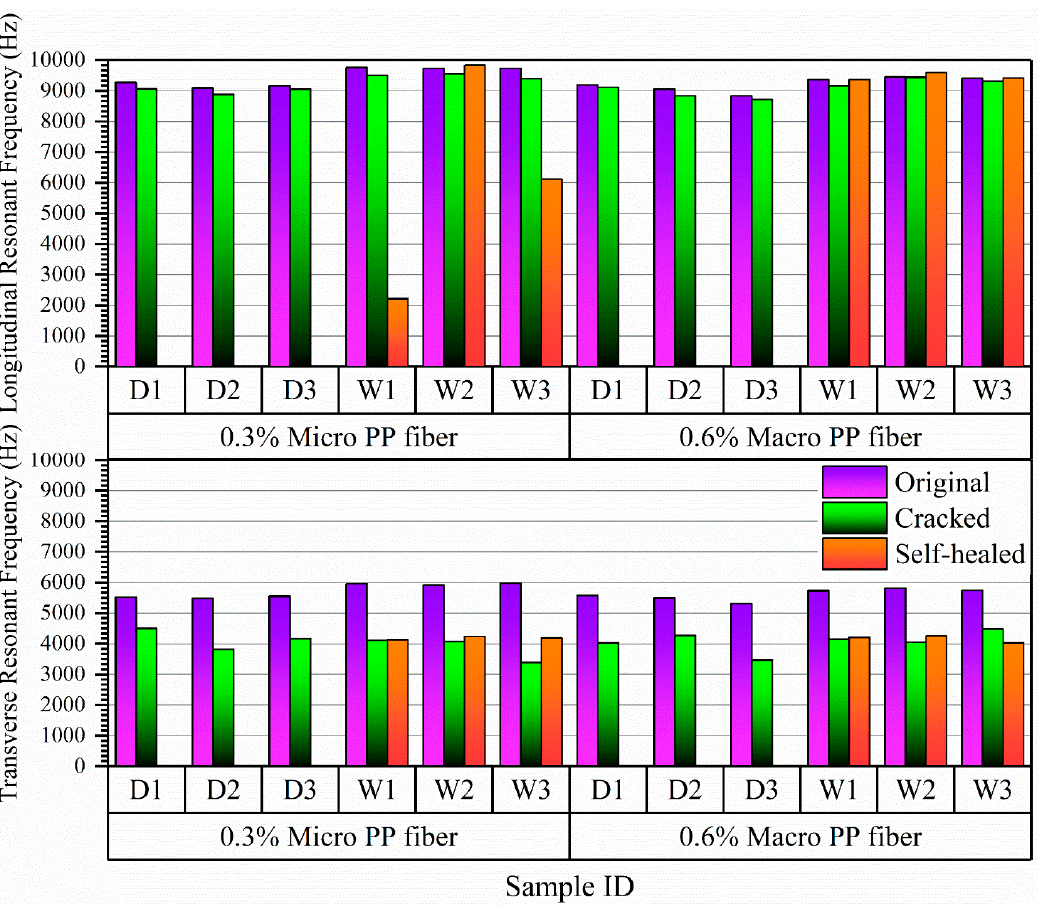
Figure 5. Frequency response of original, cracked and self-healed Polypropylene Fiber Reinforced Concrete (PFRC) samples.